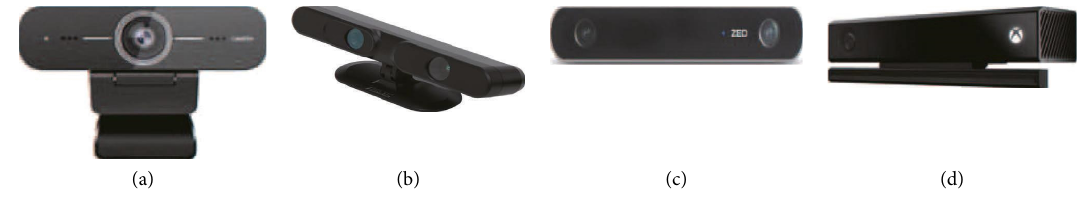
Figure 4: Te camera type: (a) the monocular camera (LinSee LS-Z50U), (b) the structured light camera (Xtion PRO), (c) the binocular camera (ZED STEREO CAMERA), and (d) the TOF camera (Kinect V2).